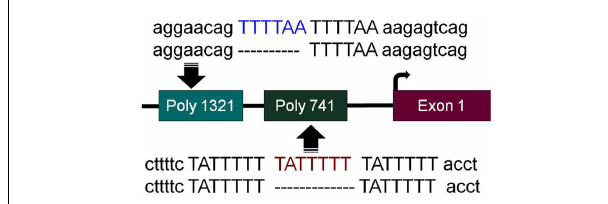
FIGURE 1 | BRM promoter polymorphisms .The two insertion polymorphisms located in the promoter of the BRM gene are illustrated here.The − 1321 polymorphic site (poly 1321) (rs3832613 or rs5925917) is located 1321bp upstream of the transcription start site and contains an additional 6bp insertion,TTTTAA, to yield a duplicate repeated sequence “TTTTAA-TTTTAA,” while the wild-type allele only has a single “TTTTAA” sequence present.The − 741 polymorphic site (poly 741) (rs34480940) is located 741bp from the transcription start site and contains an additional 7bp insertion,TATTTTT, to yield a triplicate “TATTTTT-TATTTTT-TATTTTT” sequence, while the wild-type sequence consists of the duplicate sequence